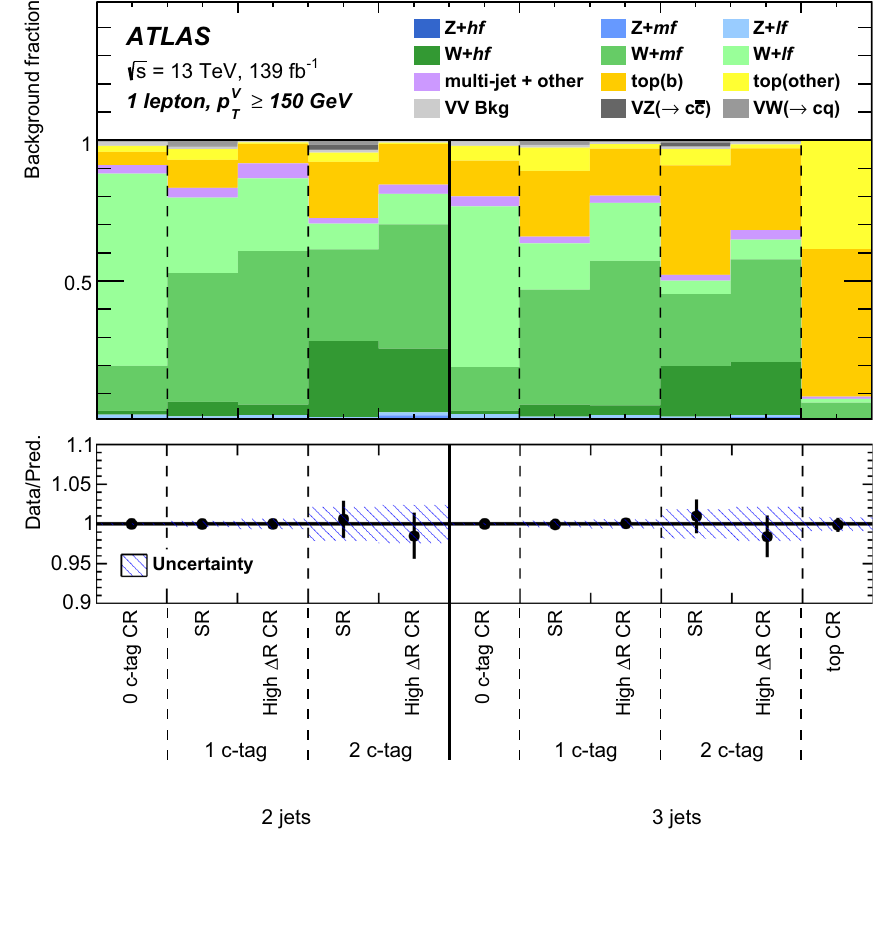
Fig. 16 The background composition in all 1-lepton signal and control